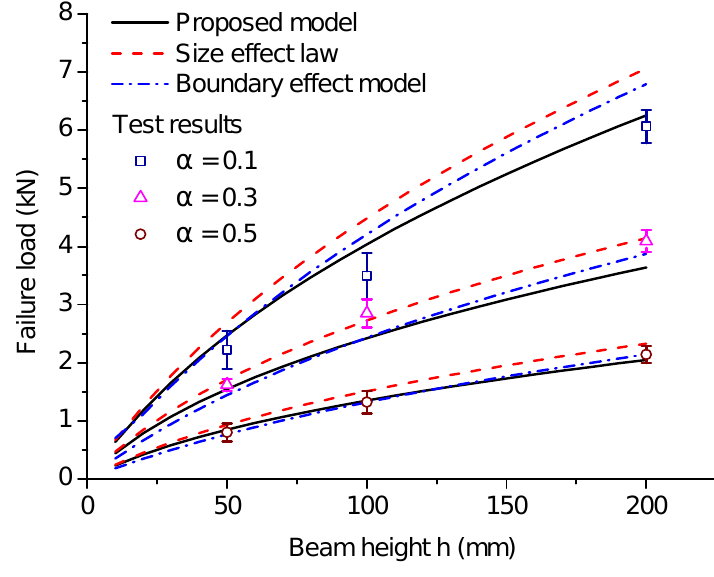
Figure 14. Model predictions of failure load versus beam height comparing with Type 2 SEL predictions, boundary effect model predictions and test results of hardened cement paste. The error bars indicate the standard deviations of the experimental